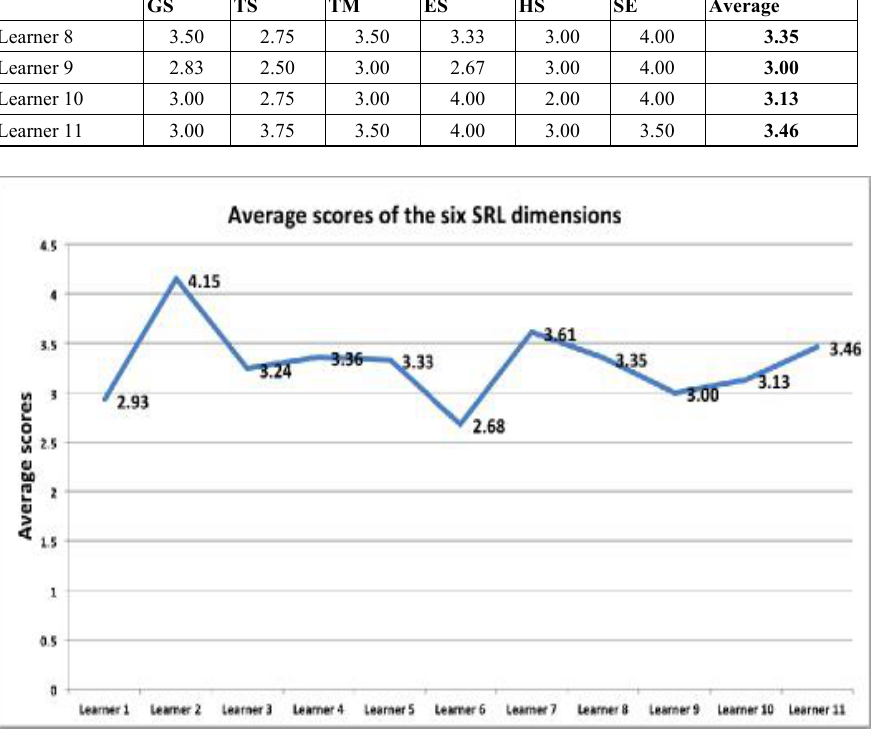
Fig. 5. Overall average score of learners from the six